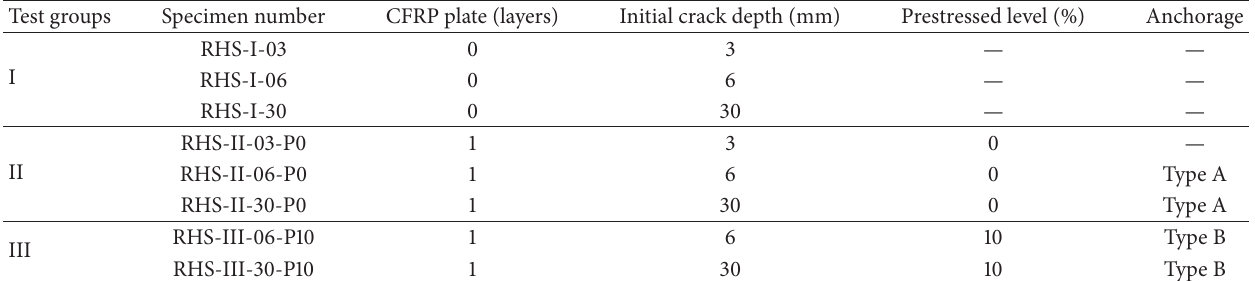
Table 2: Details of specimens.